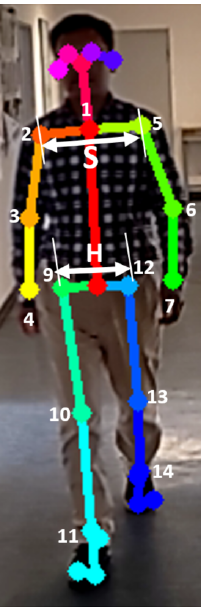
Figure 5. Pedestrian poses as detected by OpenPose (Cao et al., 2019) with the dominant keypoint features considered in our work